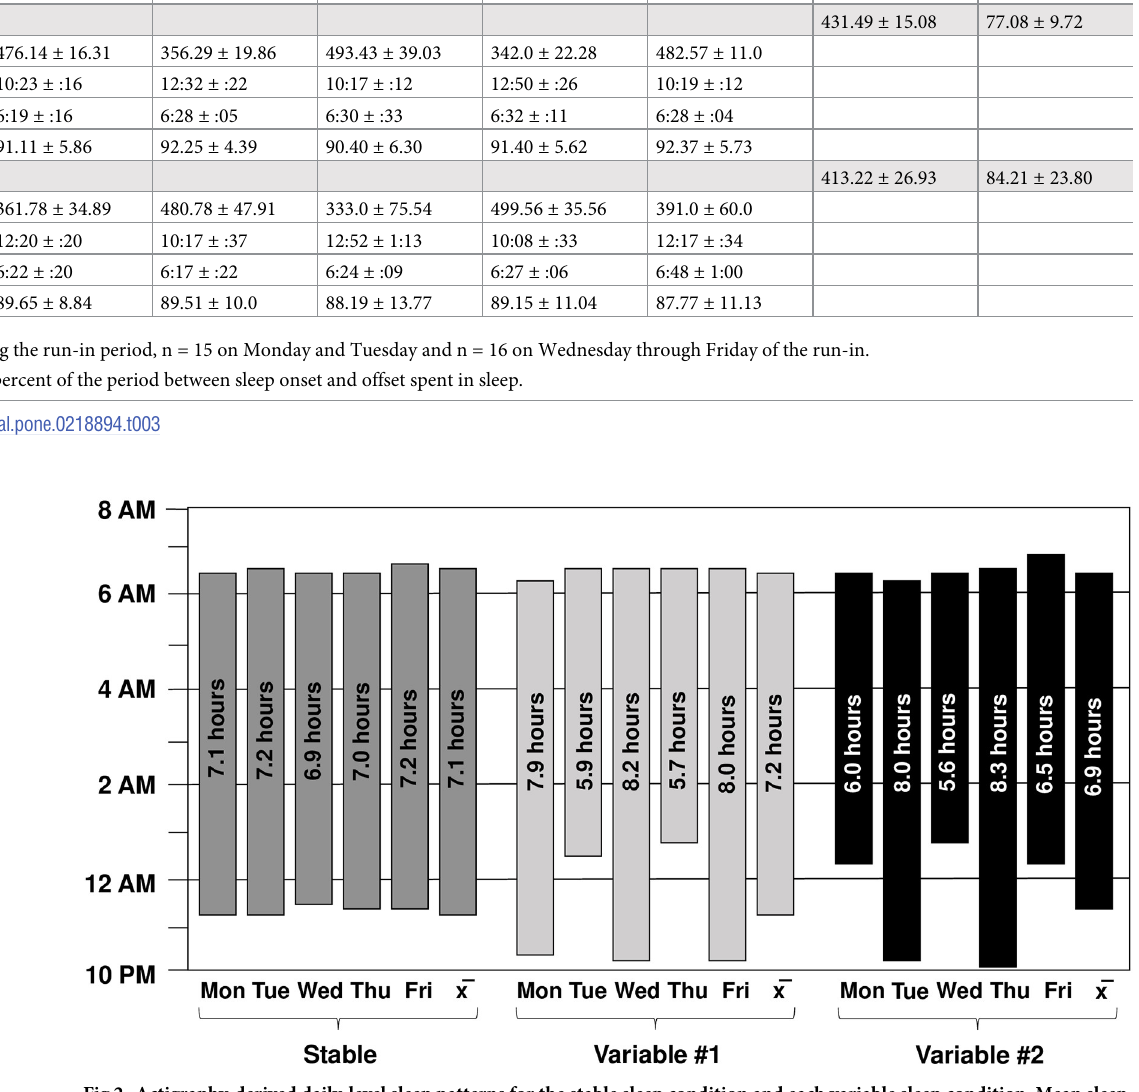
Fig 2. Actigraphy-derived daily-level sleep patterns for the stable sleep condition and each variable sleep condition. Mean sleep onset is represented by the bottom of each bar and wake time by the top with average sleep duration printed within each bar. Depiction of relative stability and variability across experimental conditions in regards to daily-level sleep onset, offset, and duration for adolescents completing the protocol with adequate adherence.